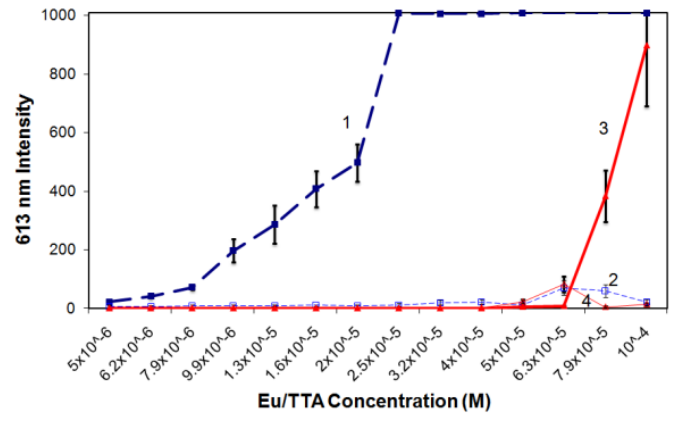
FIGURE 6 . Eu/TTA 613-nm emission in (1) fresh water with NG, (2) fresh water without NG, (3) seawater with NG, and (4) seawater without NG. The reagent solvent (methanol) comprised 5% of the